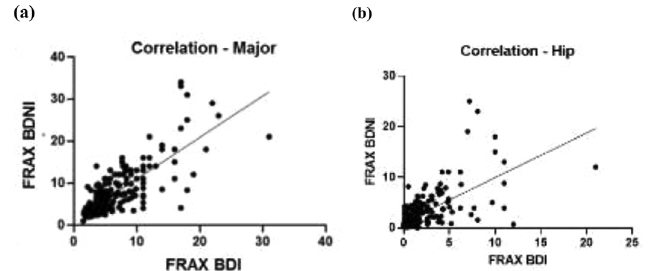
Fig. 1. Correlation of Brazilian FRAX BDNI and BDI for major fractures and hip fractures. FRAX BDNI, Brazilian FRAX calculated with Bone-Density Not Included; FRAX BDI, Brazilian FRAX calculated with Bone-Density